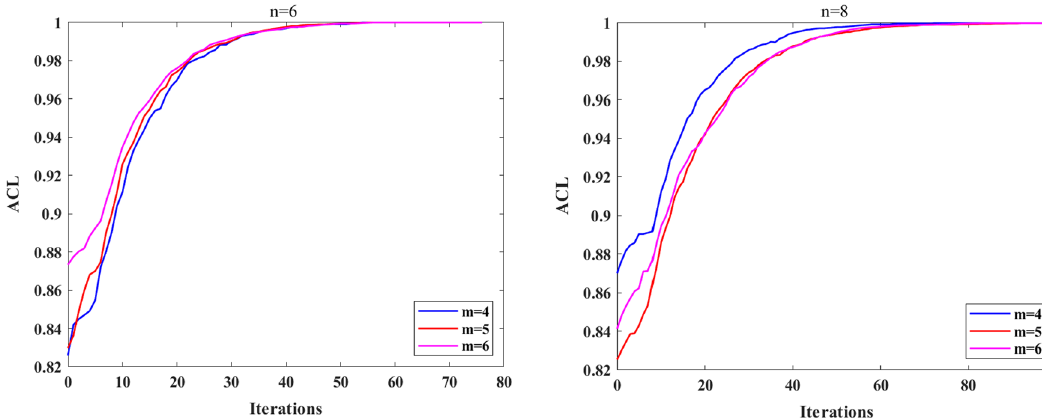
Fig. 4 Average consensus level under different